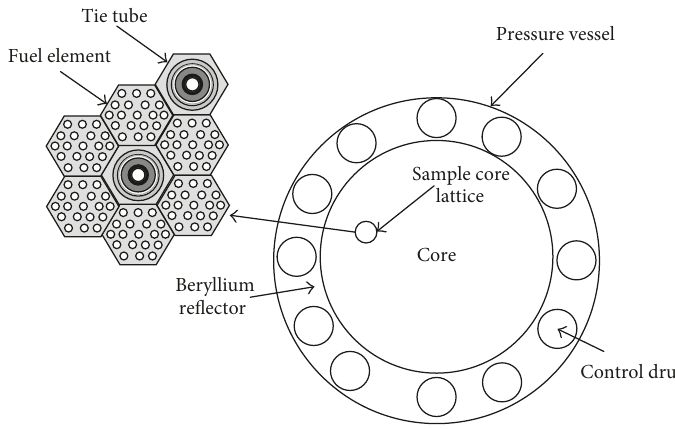
Figure 2: Top view of the core of a typical NERVA engine [11].